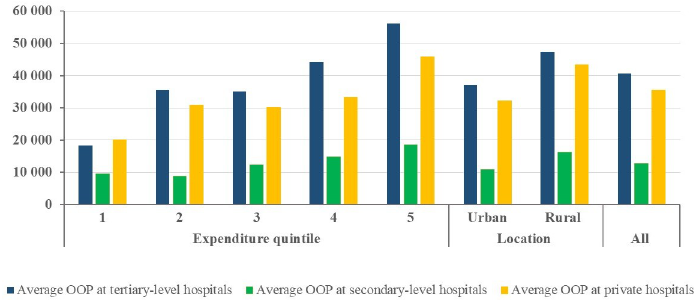
Fig 1. Out-of-pocket payments (MNT) for inpatient care at different hospitals by expenditure quintiles and locations.